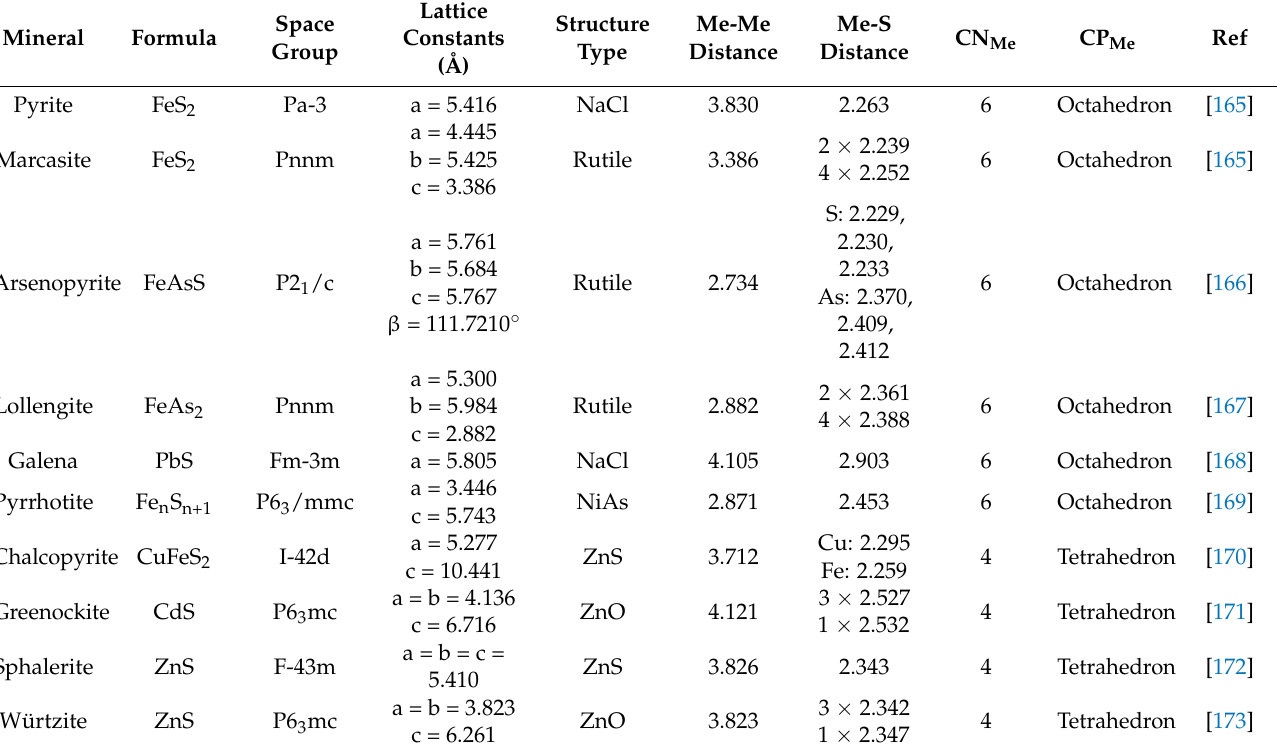
Table 29. Crystal chemical parameters of the main sulphides.